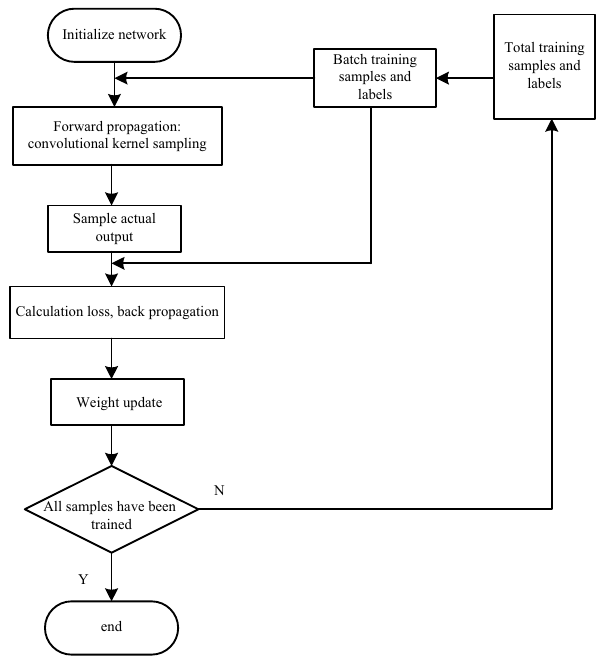
Figure 6: Optimization of social network image denoising